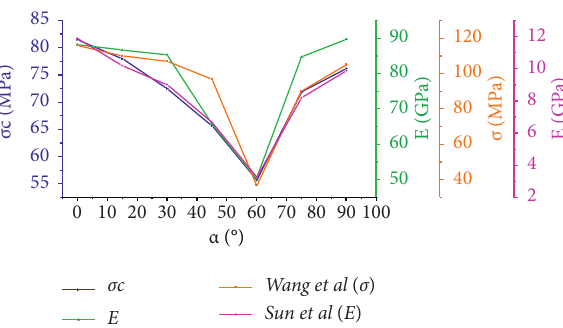
Figure 9: Elastic modulus and compressive strength of jointed sandstone with different dip angles.